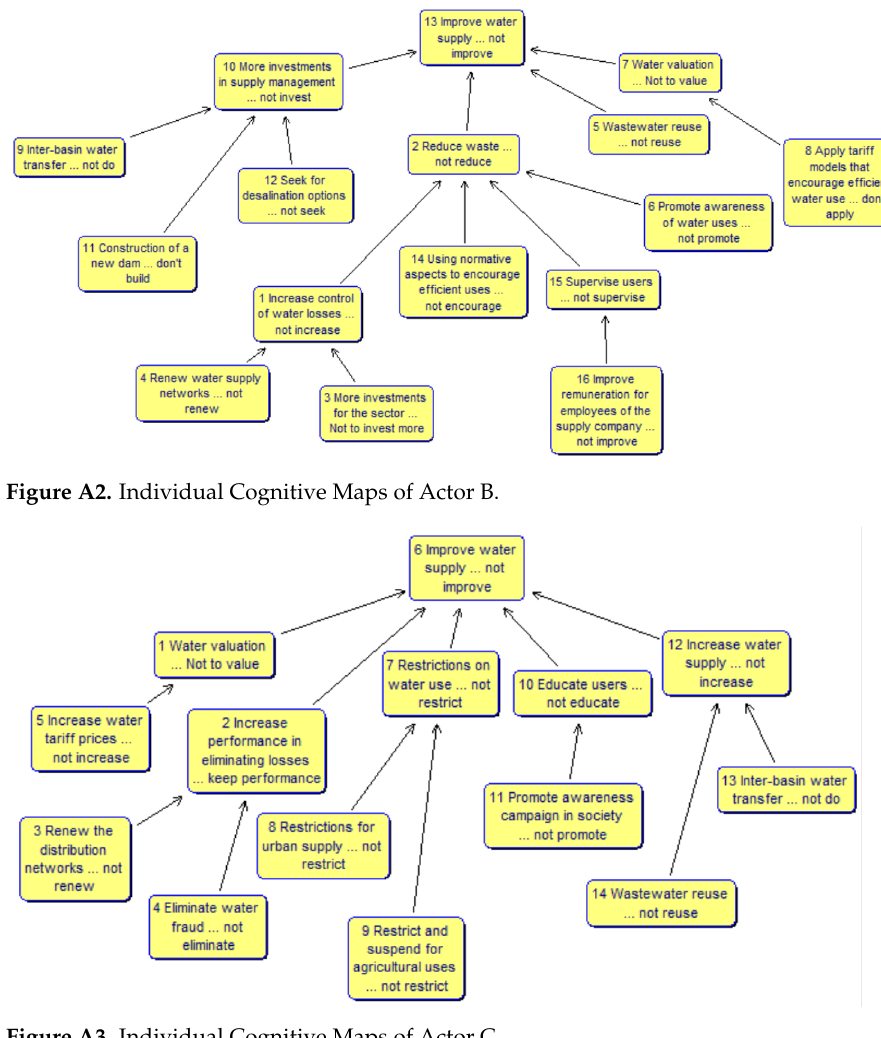
Figure A3. Individual Cognitive Maps of Actor C.